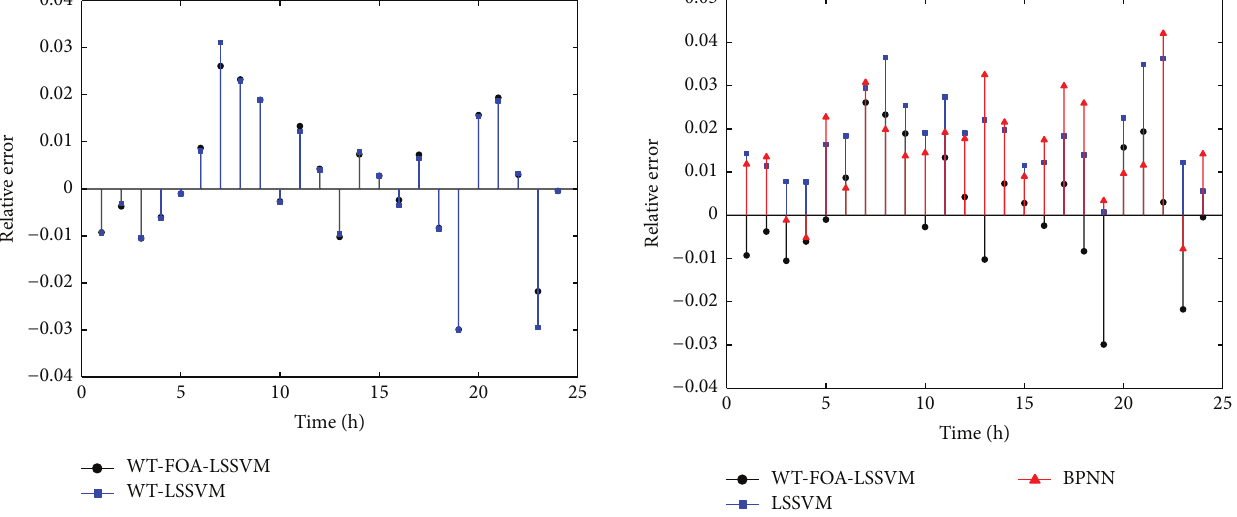
Figure 11: Relative errors of WT-FOA-LSSVM, LSSVM, and